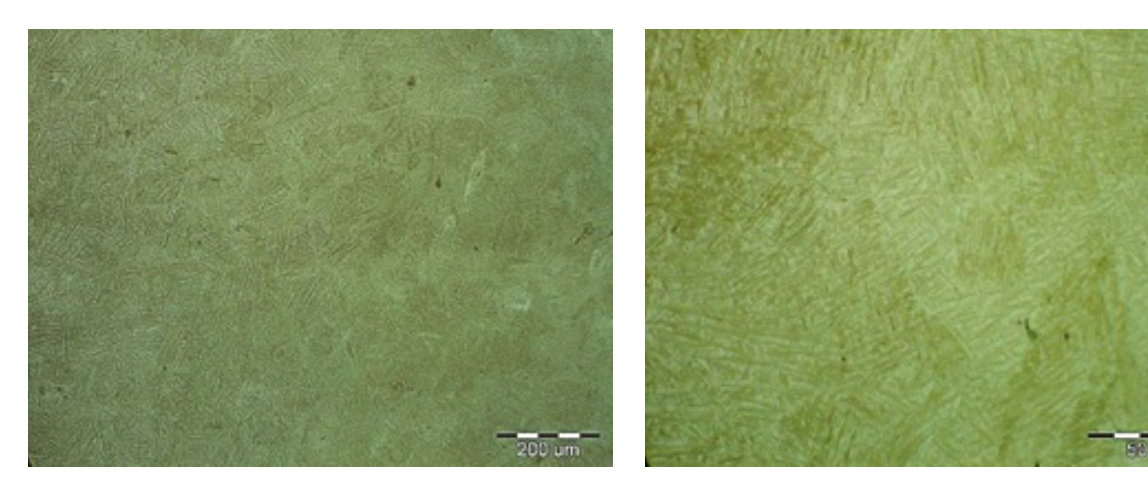
Figure 1: Microstructure of sintered material, mag. 50 x, LM.